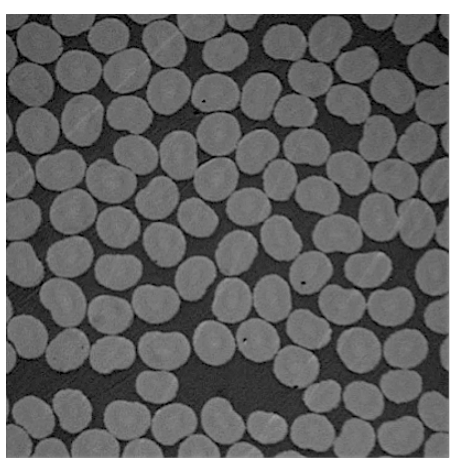
Figure 2. Random packing of fibers seen in a cross-section of a fiber tow with V